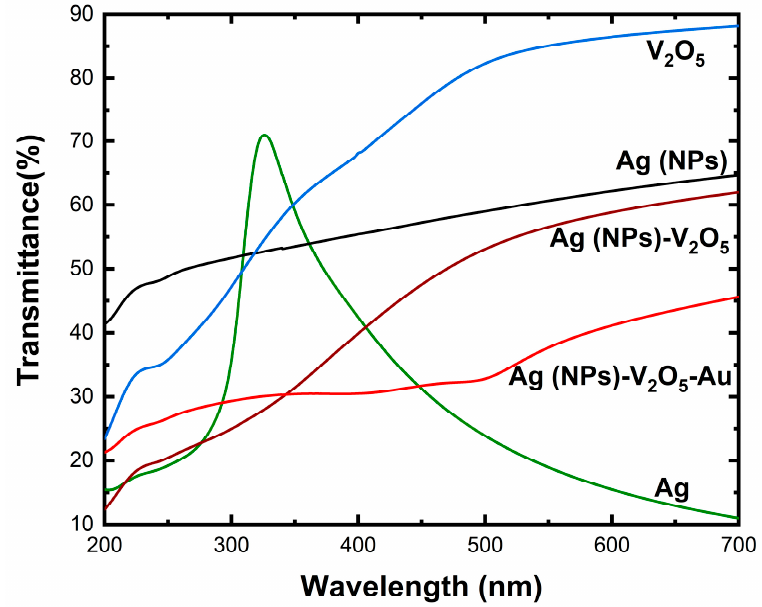
Figure 4. UV-Vis spectra of Ag thin film, Ag (NPs), V 2 O 5 thin film, Ag NPs/V 2 O 5 , and Ag NPs/V 2 O 5 thin film/Au NPs.